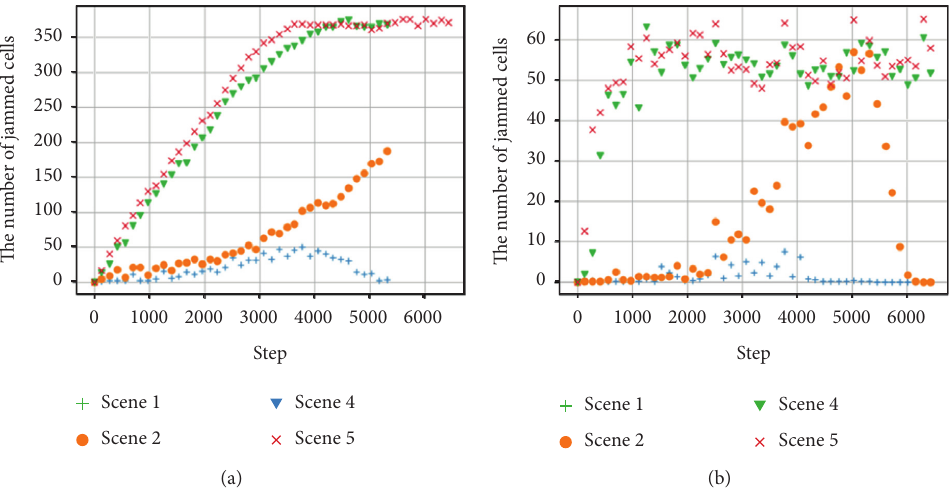
Figure 12: The number of jammed cells of a 4 × 4 network with one strategy and fixed phasing time for scenarios 1, 2, 4, and 5. By comparing the results with the fixed time traffic light, we can see that the proposed method manage the network number of jammed cells better in heavy traffic. (a) Fixed time traffic light. (b) The proposed traffic light phasing without ETL.